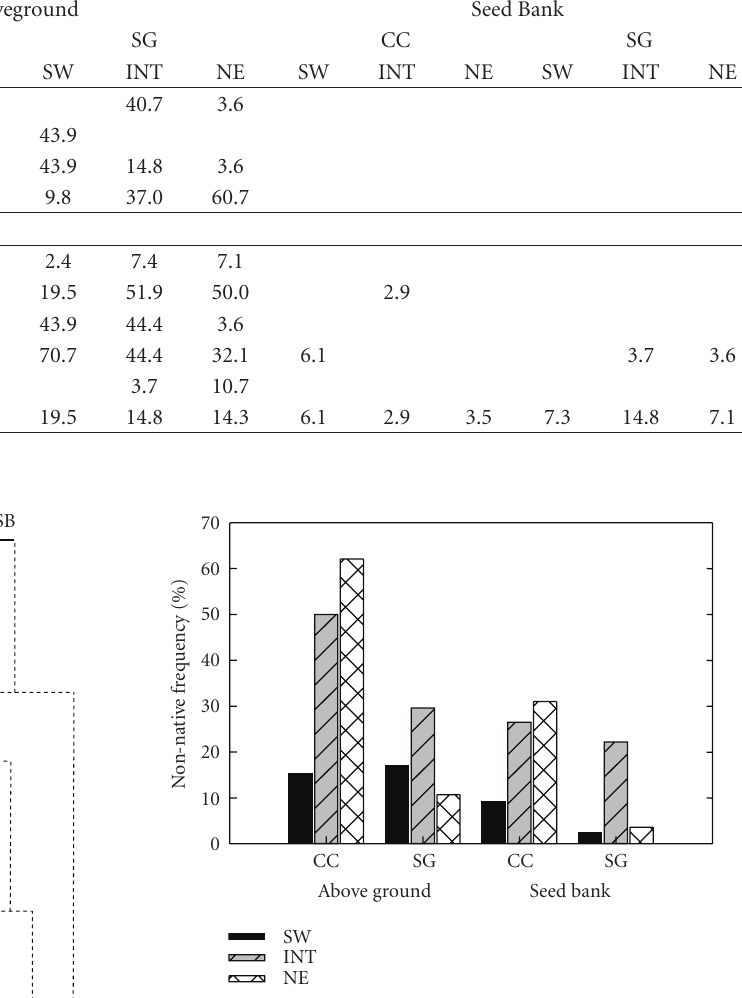
Figure 6: Frequency of nonnative plant species in aboveground and seed bank samples across the six stand age/aspect classes examined. (See text for description of